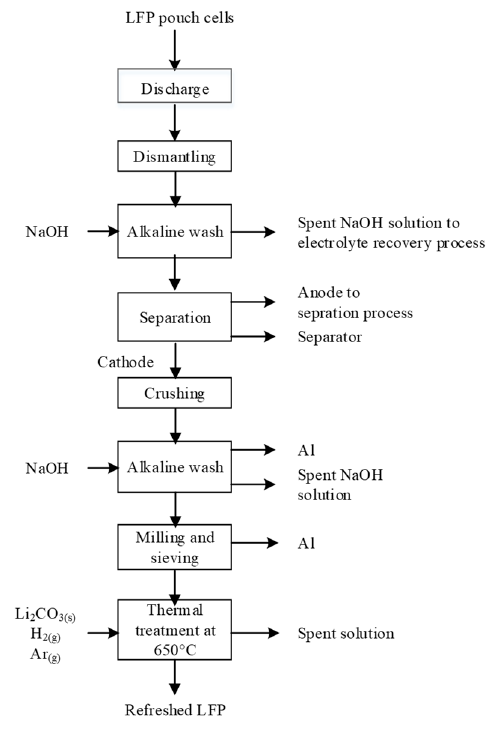
Figure 17. Pilot-scale thermal regeneration process of LFP (according to [97]).